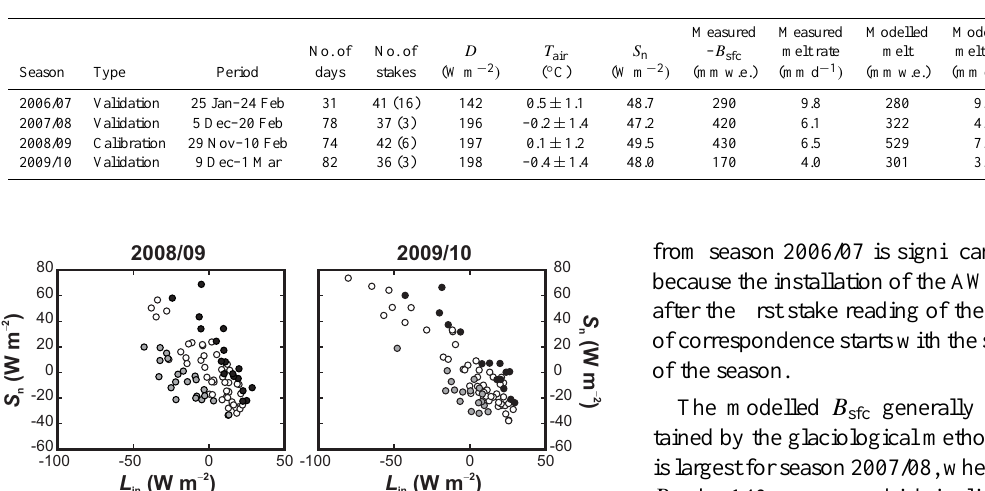
Table 5. Characteristics of model calibration and validation runs. Figures in brackets in column No. of stakes refer to the number of stakes observed in bare ice at the end of the period. B sfc values are negative (representing ablation), but in the table we display – B sfc for easy comparison with melt, which is defined as a positive quantity.